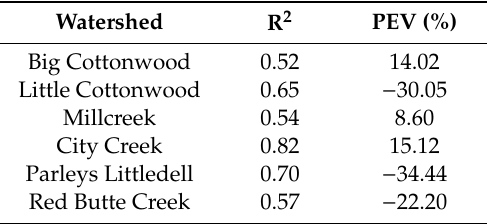
Table 7. Results of di ff erent statistical tests to evaluate the historical baseline scenario results based on annual volume of